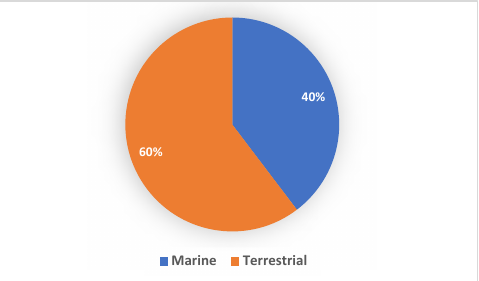
Figure 4. Distribution of Streptomyces spp. with novel/new natural products from terrestrial and marine environment between 2015 and 2020. The terrestrial Streptomyces spp. were the source of 60% of novel/new natural products while marine Streptomyces spp. were sources of only 40% of novel/new natural products.